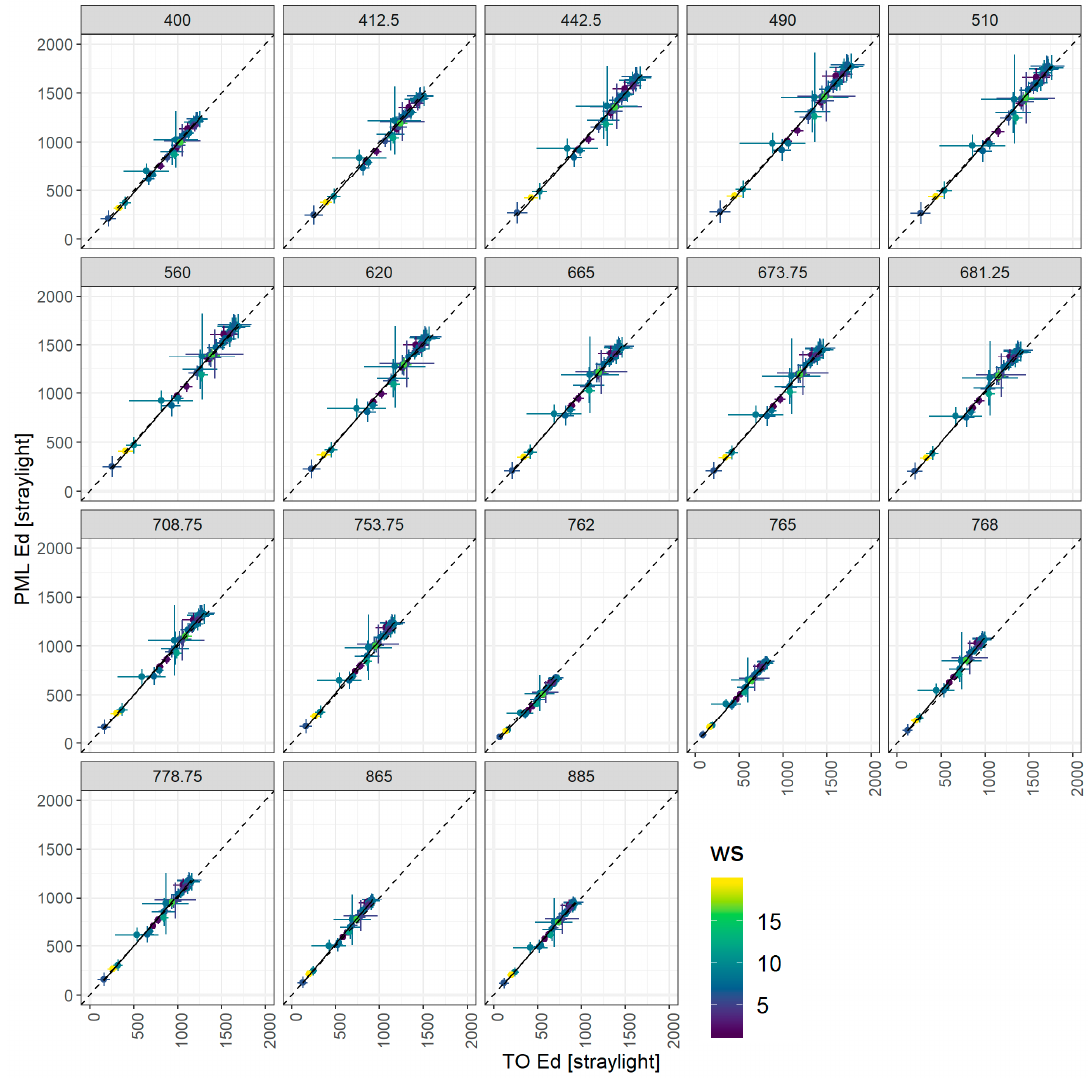
Figure A2. Comparison between TO and PML E d ( λ ) after straylight correction at OLCI’s bands.